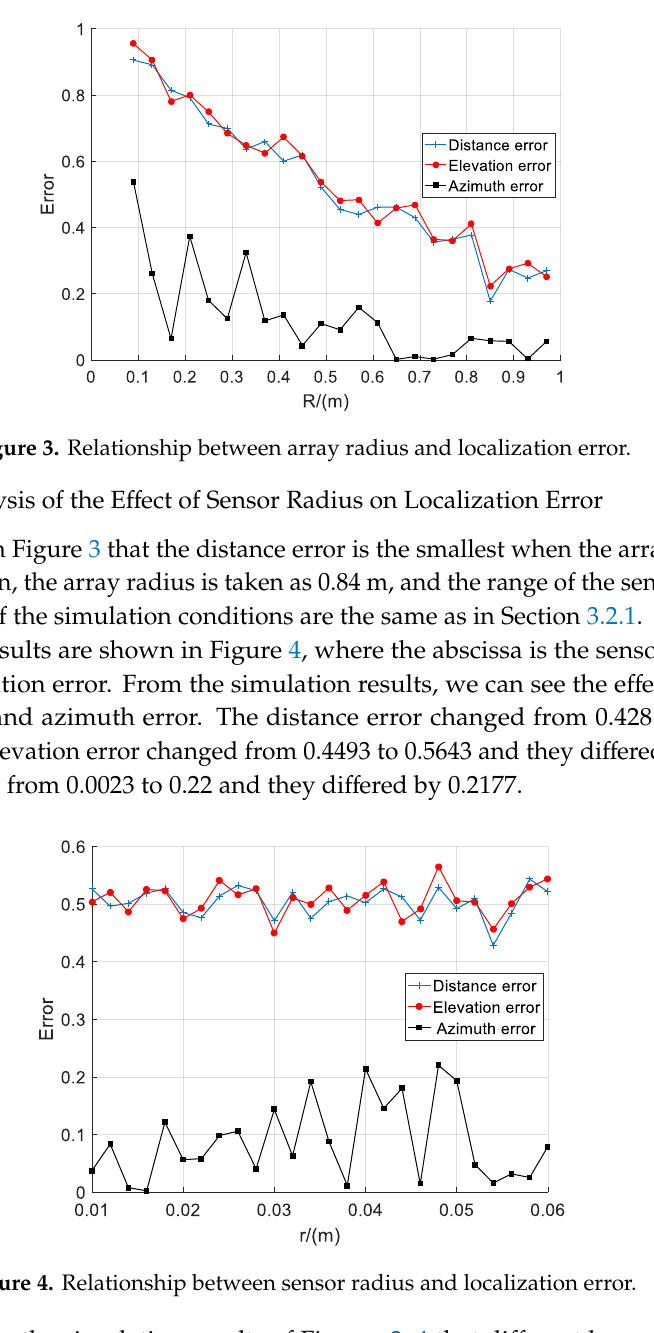
Figure 2. Relationship between number of sensors and localization error.